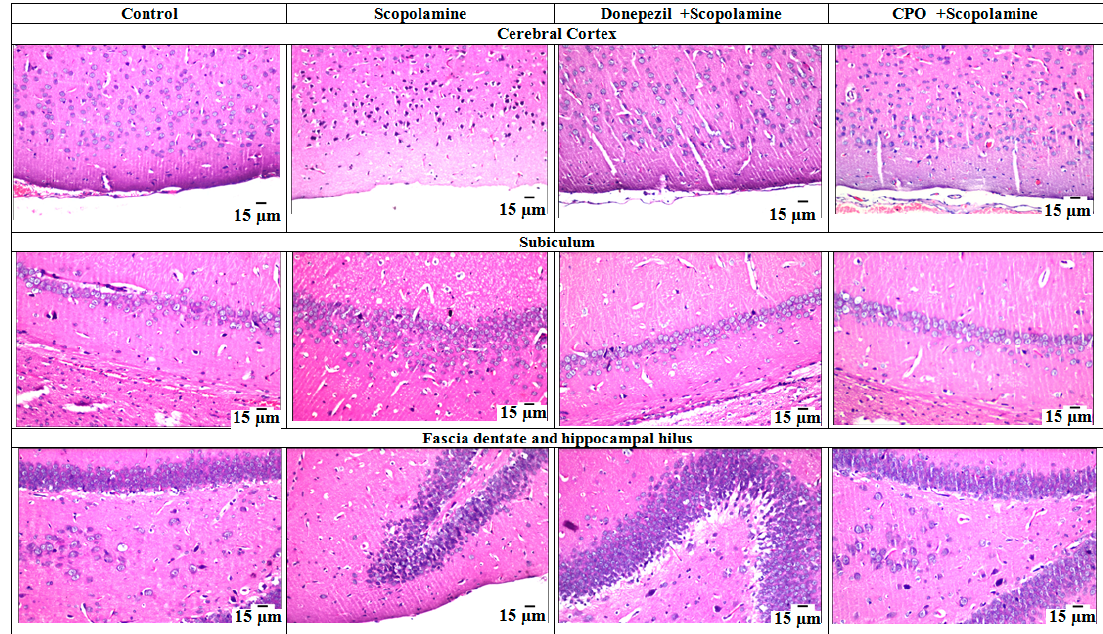
Figure 3. Microphotographs (stained by hematoxylin and eosin) showing cerebral cortex, subiculum, fascia dentate, and hippocampal hilus from the brain of rats in the control, scopolamine-, donepezil-, and pepper oil-treated groups. This figure was adopted from Mostafa [10].